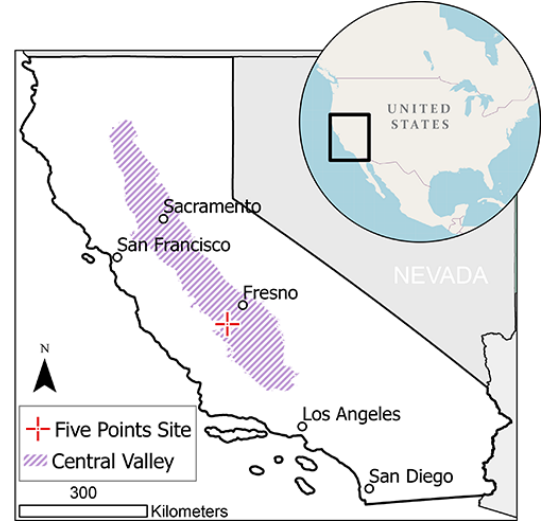
Figure 1. Location of the study site at Five Points, California (Cal- ifornia’s Central Valley extent map from Faunt,